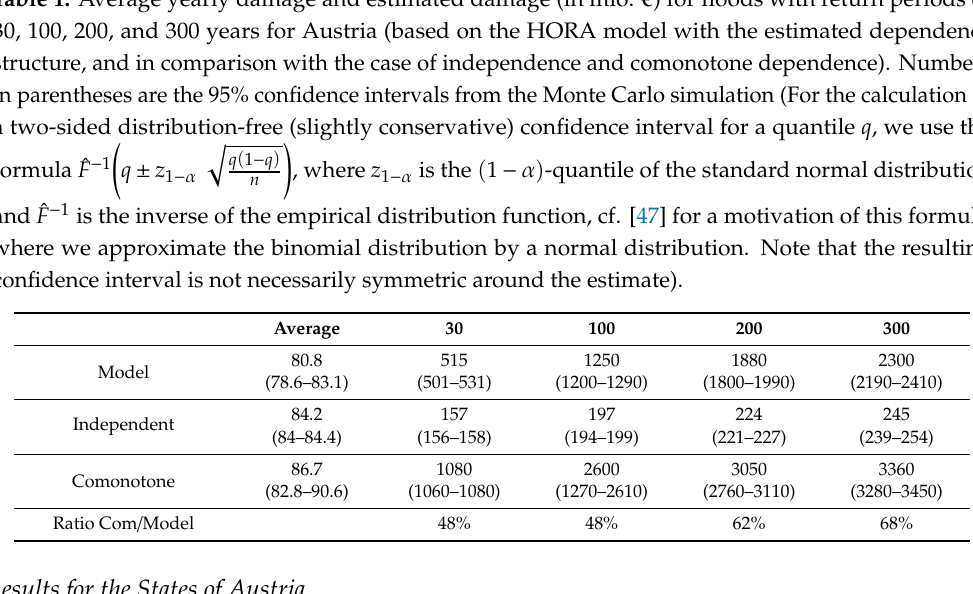
Table 1. Average yearly damage and estimated damage (in mio. € ) for floods with return periods of 30, 100, 200, and 300 years for Austria (based on the HORA model with the estimated dependence structure, and in comparison with the case of independence and comonotone dependence). Numbers in parentheses are the 95% confidence intervals from the Monte Carlo simulation (For the calculation of a two-sided distribution-free (slightly conservative) confidence interval for a quantile q , we use the